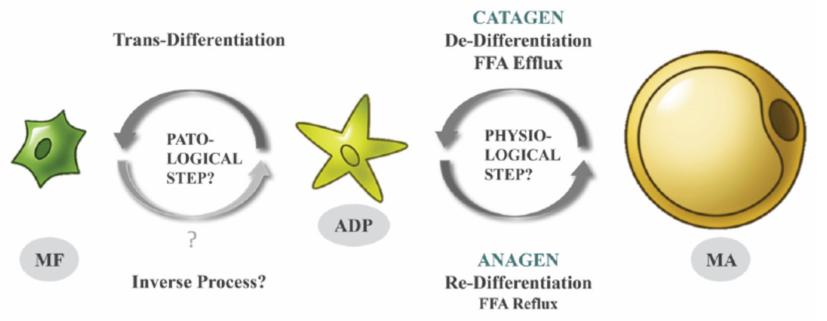
Figure 1. De-, re-, and trans-differentiation of dermal adipocytes during the HF cycle [9] (with permission from Experimental